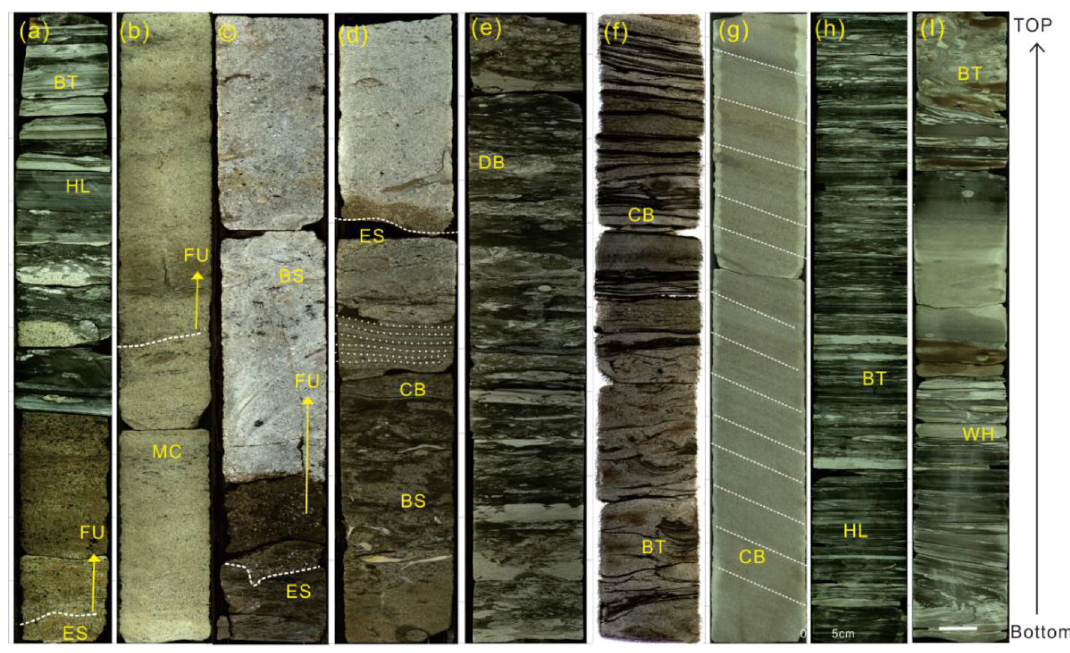
Figure 3. Core photos of braided river delta and meandering river delta deposits: ( a ) Braided interdistributary bay deposit(FA2); ( b ) Braided distributary channel deposits(FA1) (location of cores a , b shown in Fig. 5, borehole W3 in Fig. 1b, 2620–2627 m depth; S1); ( c ) Subaqueous distributary channel deposits of braided river delta front: (FA3); ( d ) Estuary dam deposits of braided river delta front(FA4) (location of cores c , d shown in Fig. 5, borehole W4 in Fig. 1b, 2164–2180 m depth; S2); ( e ) Distal bar deposits of braided river delta front(FA5); ( f ) subaqueous interdistributary bay deposits of braided river delta front(FA6) (location of cores e , f shown in Fig. 5, borehole W2 in Fig. 1b, 2297–2289 m depth; S2); ( g ) distributary channel deposits of meandering river delta plain(FA7); (h) Distal bar deposits of meandering river delta plain (FA11); ( i ) subaqueous